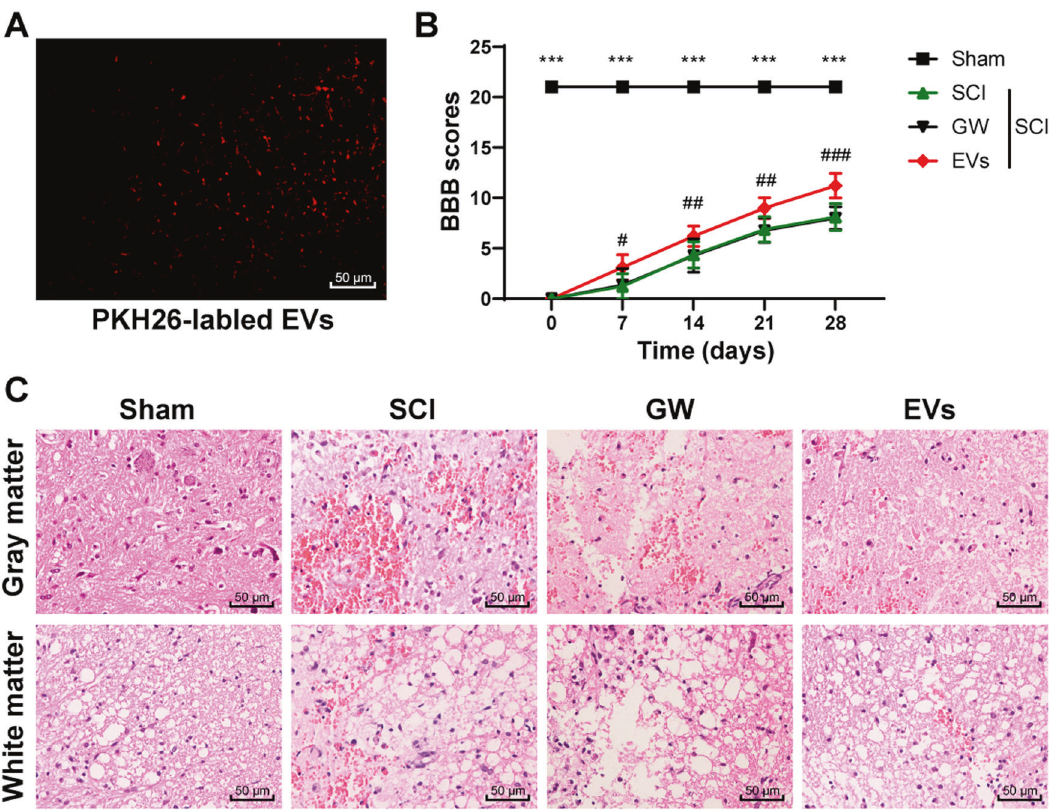
immuno fl uorescence. B the motor function of rats in each group was evaluated by BBB scale on the 0, 7th, 14th, 21st, 28th day after the operation. C the pathological changes of spinal cord tissues were measured using HE staining on the 28th day after the operation. N = 6.